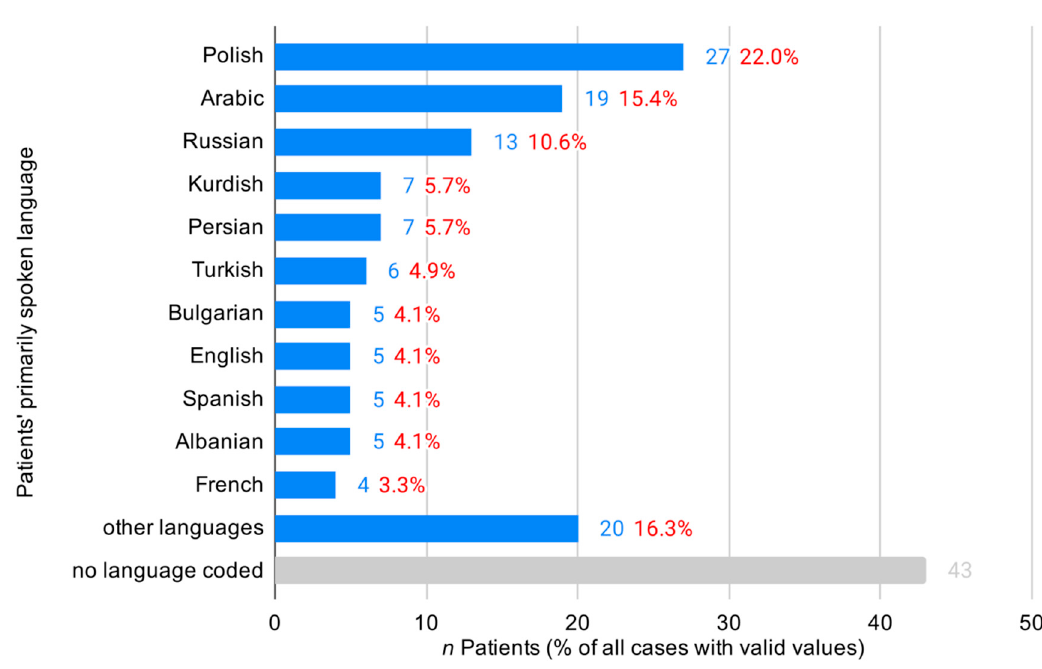
Figure 3. Distribution of patients’ primarily spoken language.